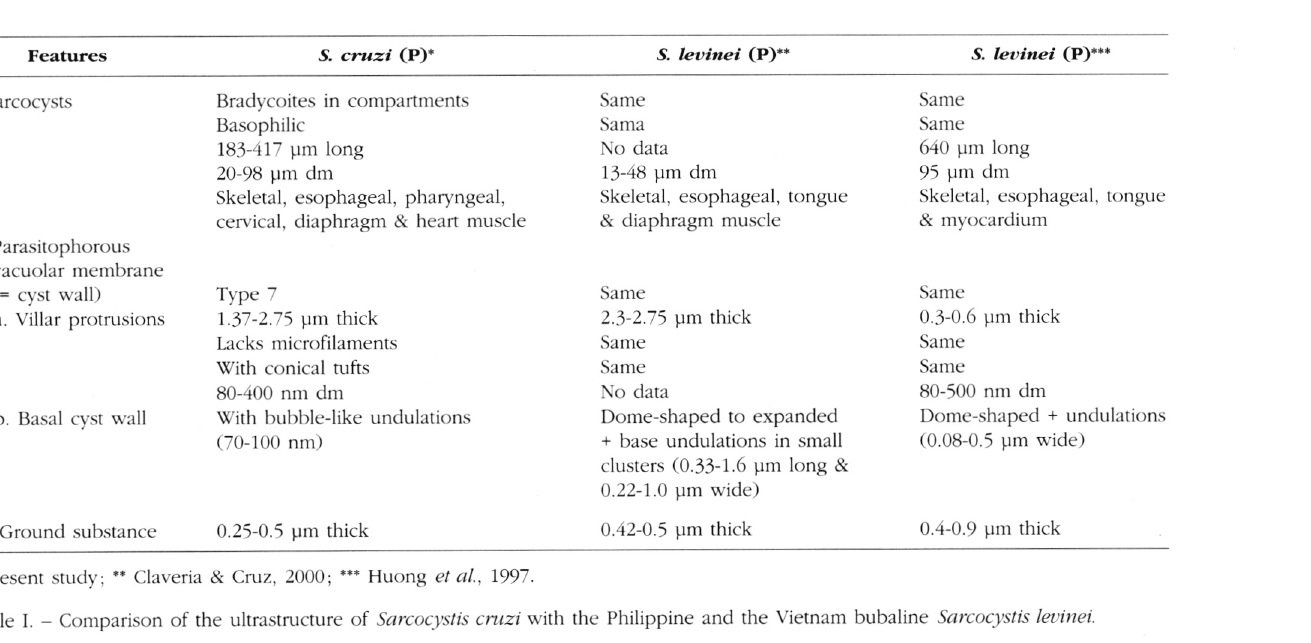
Table I. - Comparison of the ultrastructure of Sarcocystis cruzi with the Philippine and the Vietnam bubaline Sarcocystis levinei. Parasite, 2001, 8,